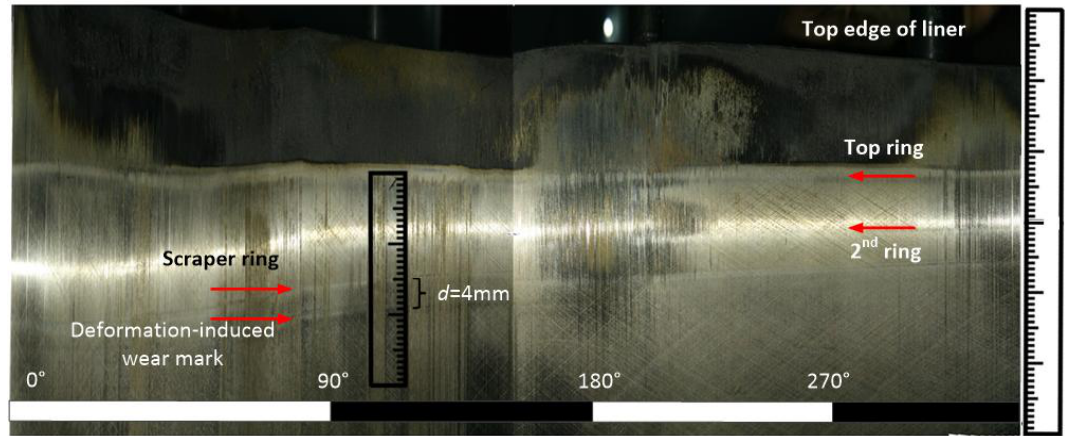
Figure 17. Panoramagram of the inner surface of a used liner (Unit: mm).